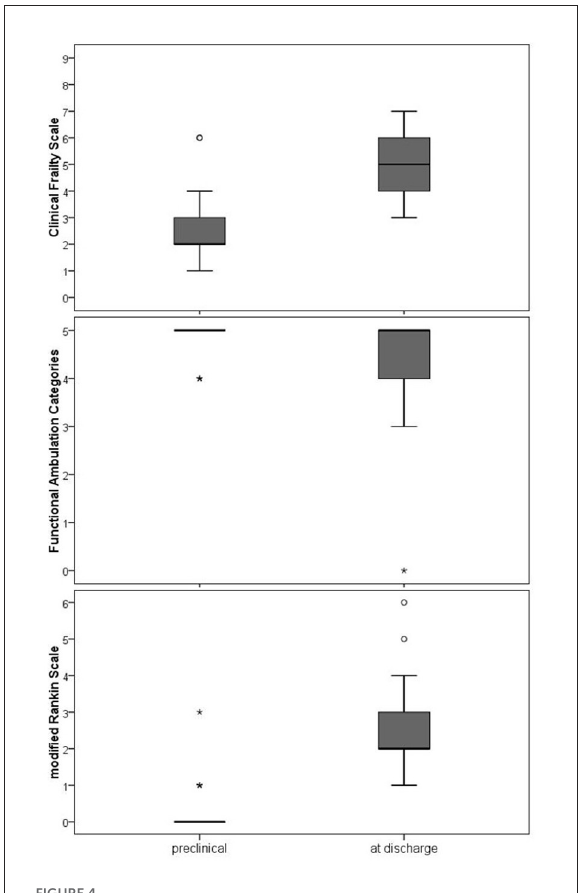
FIGURE4 Walking ability, frailty and overall disability at clinical discharge compared to the preclinical condition. FAC (Functional Ambulation Categories), Frailty (Clinical Frailty Scale), mRS (modified Rankin Scale). The Wilcoxon test was used to compare the preclinical state and the state at discharge. All three comparisons differed statistically significant ( p <